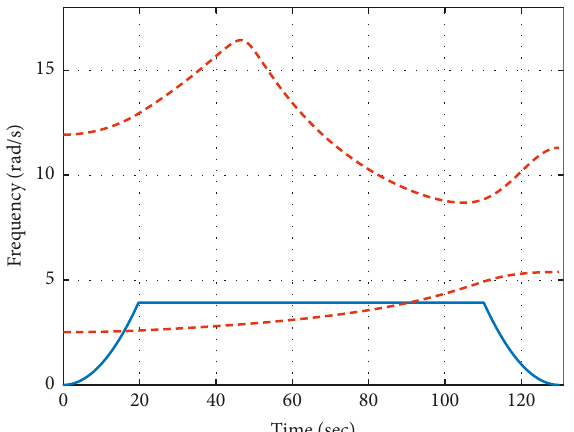
Figure 4: Natural frequency of the longitudinal vibration (red line) and frequency of excitation (blue line).